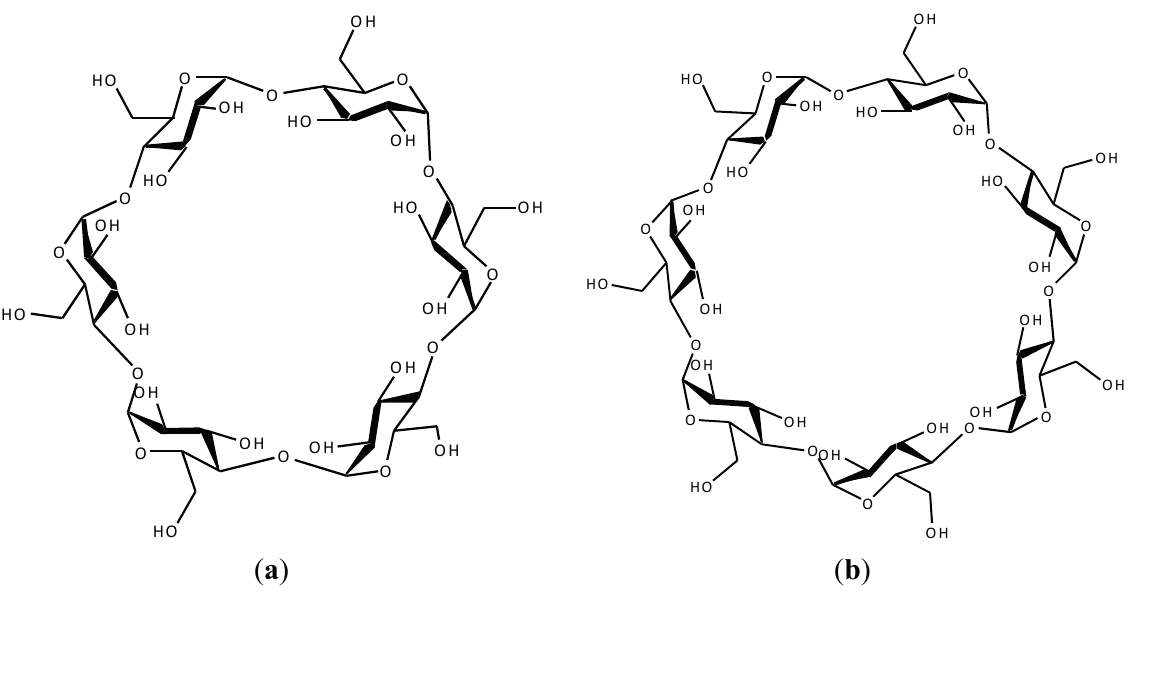
Figure 1. Chemical structures of ( a ) α -cyclodextrin ( α -CD); ( b ) β -cyclodextrin ( β -CD); and ( c ) γ -cyclodextrin ( γ